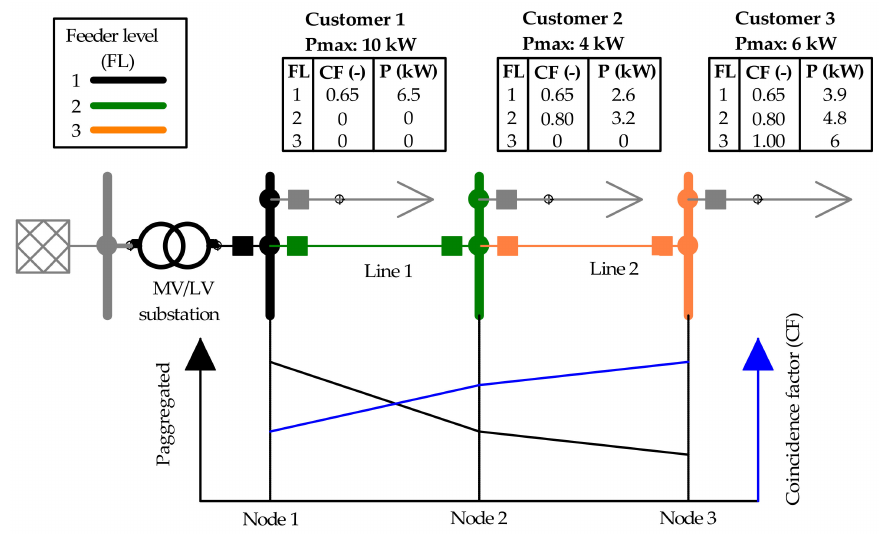
Figure 5. Exemplary allocation of coincidence factors (CF) and resulting power (P) to the grid’s customers depending on the analyzed feeder level (FL).